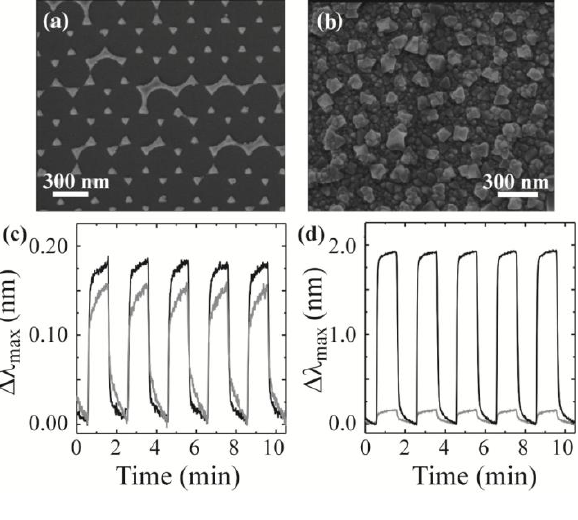
Figure 4. SEM images of ( a ) a triangular silver nanoparticle array fabricated by nanosphere lithography on a glass coverslip and ( b ) silver nanoparticle array coated with benzenetricarboxylate forming the MOF sensor platform; ( c ) Response of the bare nanoparticle sensor to SF (black) and CO (gray); ( d ) Response of the bare nanoparticle (gray) and 6 2 MOF-coated nanoparticle (black) to CO . The coating increases the response by approximately 2 an order of magnitude. Adapted with permission from reference [129] © 2010